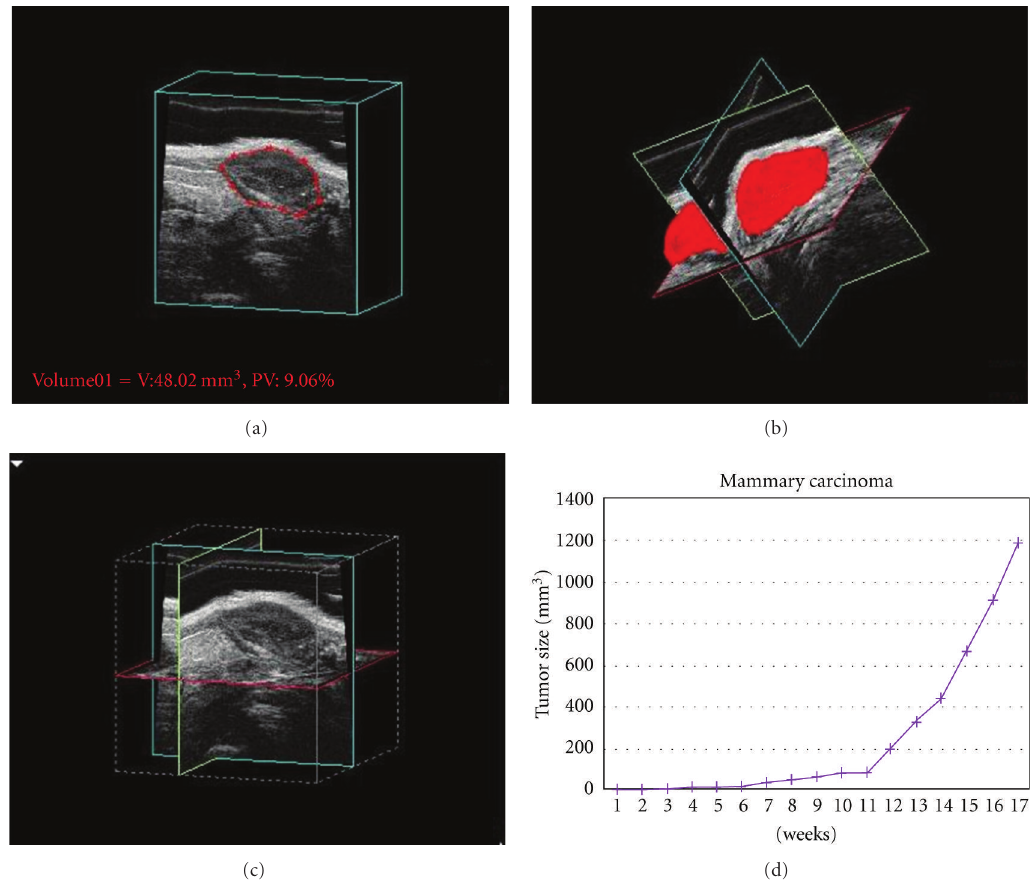
Figure 2: Various view of three-dimensional reconstructions of a subcutaneous tumor from two bidimensional successive parallel cross- section images. (a) Cube view. On the bottom, the segmentational volumetric analysis with a volume estimation of 48.02 mm 3 . (b) Surface view. (c) Cross view. (d) Quantitative analysis of tumor growth in a mice model of mammary tumor. The tumor growth curve over time is showed in the